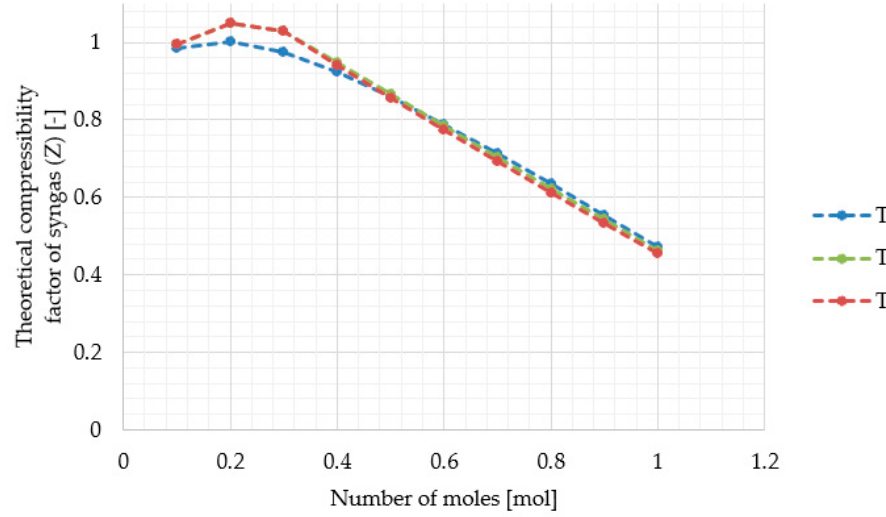
Figure 19. The theoretical value of the compressibility coefficient Z from the gasification of O 2. For the gasification of SS with hydrogen, the largest value of the B syn coefficient was 196.84 for 0.4 moles of hydrogen per mole of carbon at 973 K. The smallest value of the 175.23 coefficient was obtained for four moles of hydrogen per mole of carbon at 1473 K. The highest energy content in the transport unit was 65,296.98 MJ for 0.4 moles of hydrogen per mole of carbon at 973 K, the smallest being 38,227.50 MJ for four moles of hydrogen per mole of carbon in 1473 K (Figures 20–22).